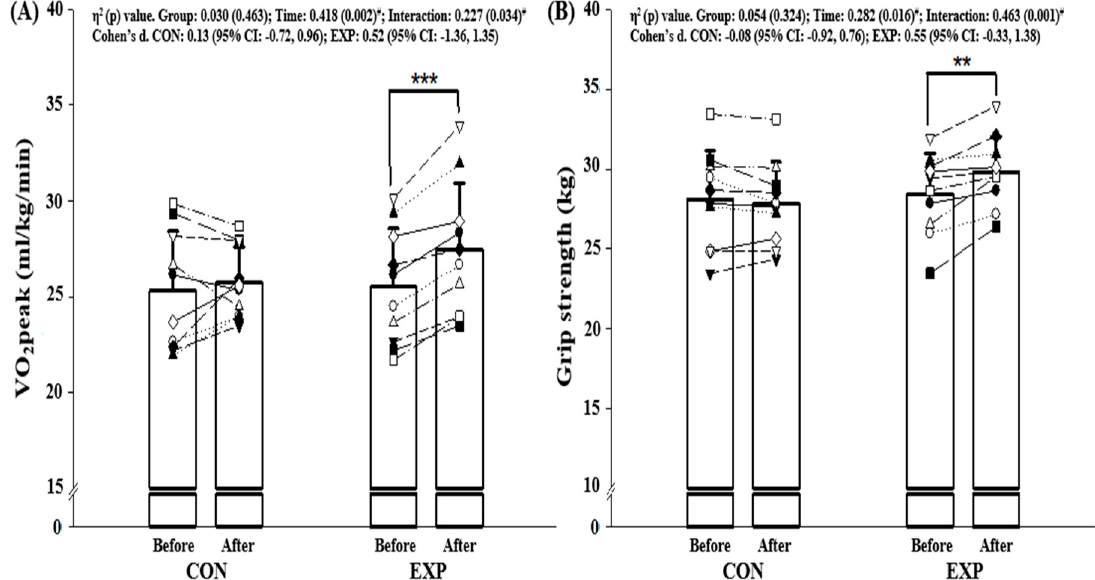
Figure 2. Changes in physical performance parameters before and after 12-week intervention: ( A ) VO 2 peak and ( B ) grip strength. Note. Values are expressed as mean (± standard deviation), CI = confidence interval, CON = control group, EXP = experimental group, each symbol ( □，△，○， etc.) represents the individual participant's pre-test and post-test values, VO 2 peak = peak oxygen uptake. # Significant interaction or main effect, ** p < 0.01, *** p < 0.001 vs. before intervention.